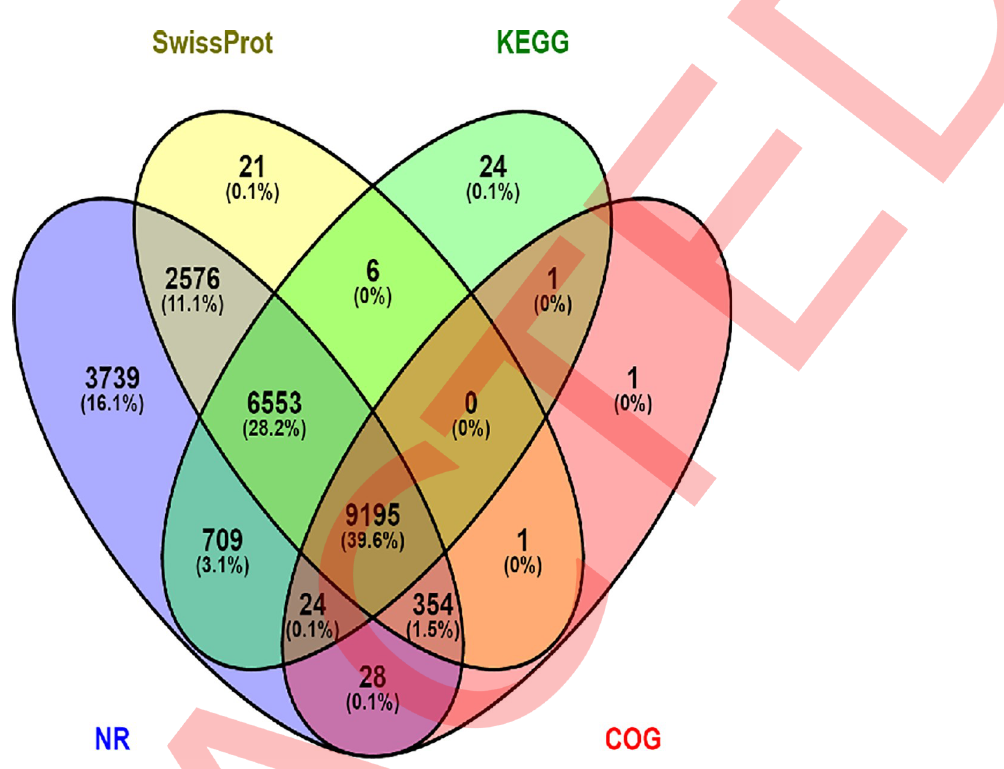
Fig 5. Venn diagram of annotated unigenes from the Rhynchophorus ferrugineus fat body tissues transcriptome sequence using BLASTX (E-value < 0.00001) and protein databases Swiss-Prot, KEGG, NR, and COG.